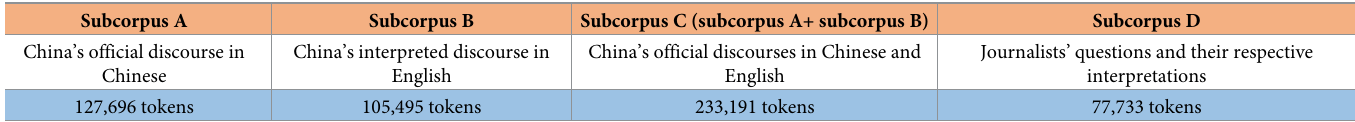
Table 1. The CE-PolitDisCorp